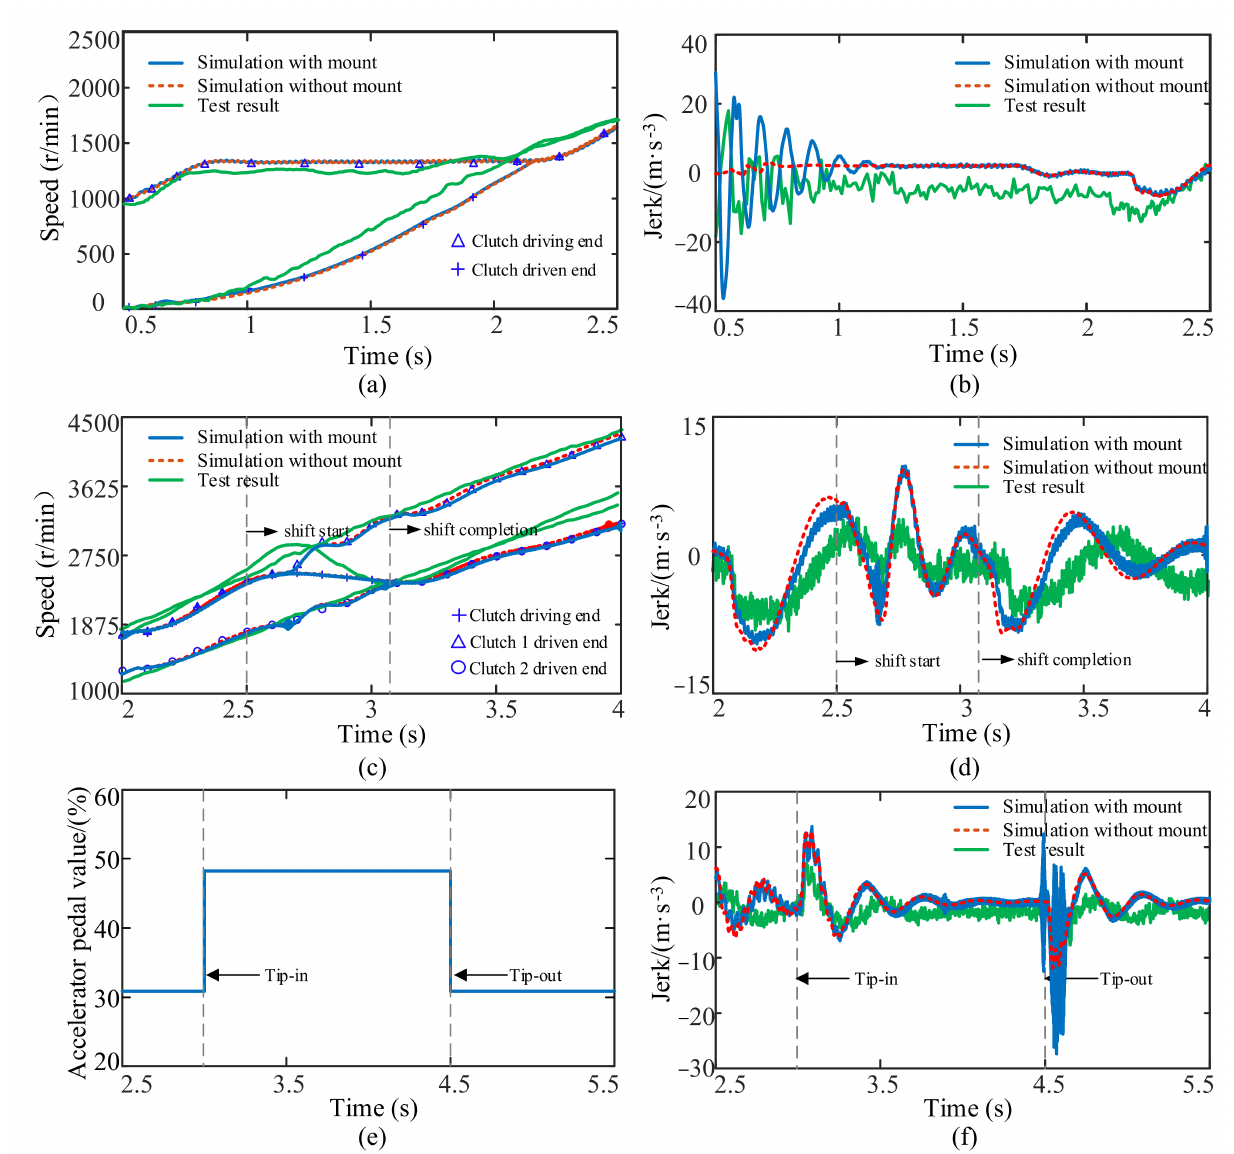
Figure 11. Comparison of test and simulation results under typical working conditions: ( a ) compar- ison of the test and simulation speeds at starting; ( b ) comparison between the test and simulation jerking at starting; ( c ) comparison between the test and simulation speeds under shifting; ( d ) compar- ison between the test and simulation jerking under shifting; ( e ) the test and simulation accelerator pedal changes under the tip-in/tip-out condition; ( f ) comparison between test and simulation jerking under the tip-in/tip-out